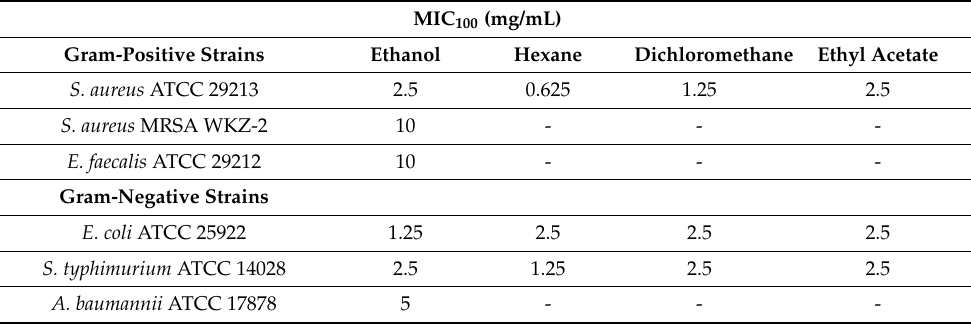
Table 1. MIC 100 values (mg/mL) determined for E. foeminea ethanolic, hexane, dichloromethane and ethyl-acetate extracts tested on a panel of gram-positive and gram-negative bacterial strains. (-) indicates not tested samples. Reported data refer to three biological